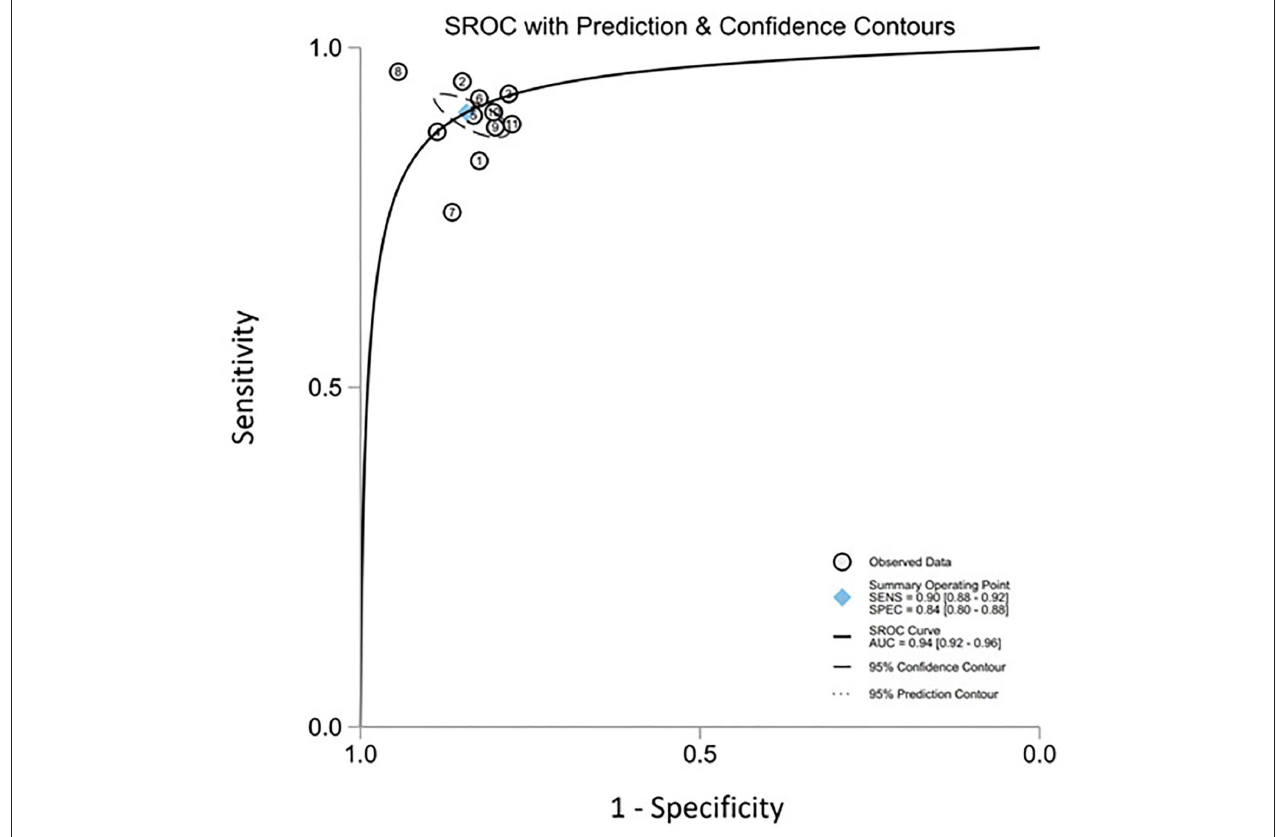
FIGURE 5 | Summary of the receiver operating characteristics (SROC) curve of all included studies.